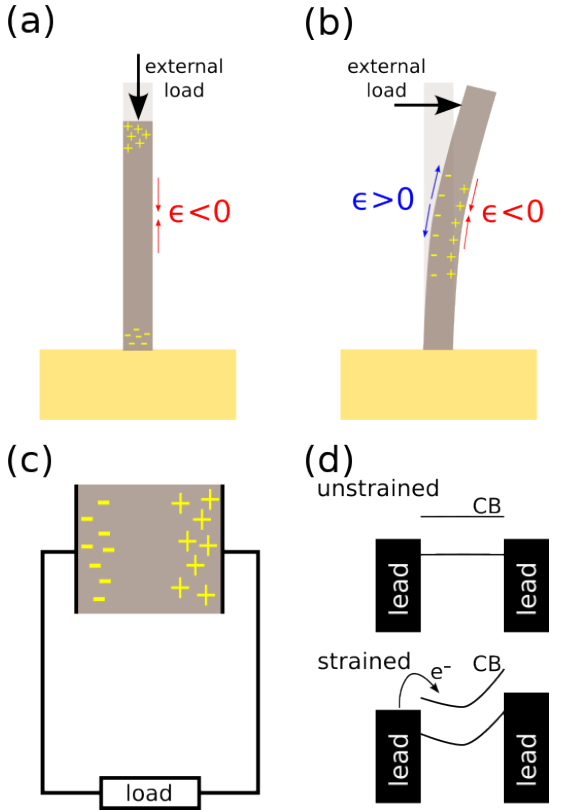
Figure 7. Schematic of the functioning modes for a 1D piezoelectric structure. ( a ) Compress- ing/stretching mode: a force applied along the length of the structure (black arrow) produces the charge separation responsible of the creation of the piezoelectric potential; ( b ) Bending mode: in this case, the structure behaves as a cantilever. The bending force (black arrow) produces a strain profile across the structure thus modulating the charge accumulation depending on local strain; ( c ) Dissipation circuit: whenever the piezoelectric potential is aligned with the electrodes, the dy- namic modulation of the charge concentration at the leads induce a measurable current. Further conditioning circuits are usually used to optimize the harvested power output; ( d ) Device band structure: electronic band structure for the non-strained (upper panel) and strained (lower panel) showing the modulation of the valence and conduction band (CB) along the 1D material. During deformation cycles charge is pumped to the conduction band close to the left-side lead. Part of this charge is released to the right-side lead during releasing